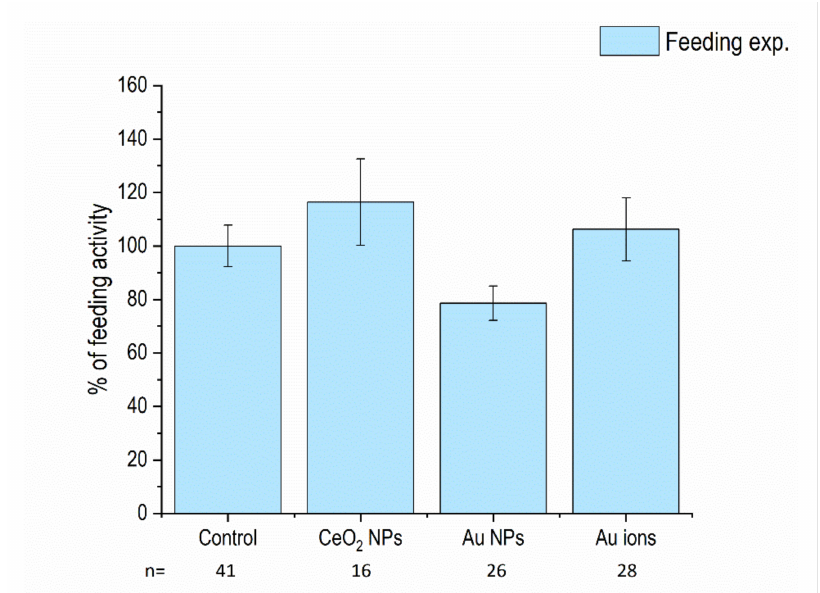
Figure 1. Feeding activity of isopods in comparison to control (%) after 14 days of feeding on CeO 2 nanoparticle (NP)-, Au NP-, and Au ions-spiked leaves. Columns represent the mean ( ± SE). n = number of biological repeats in each